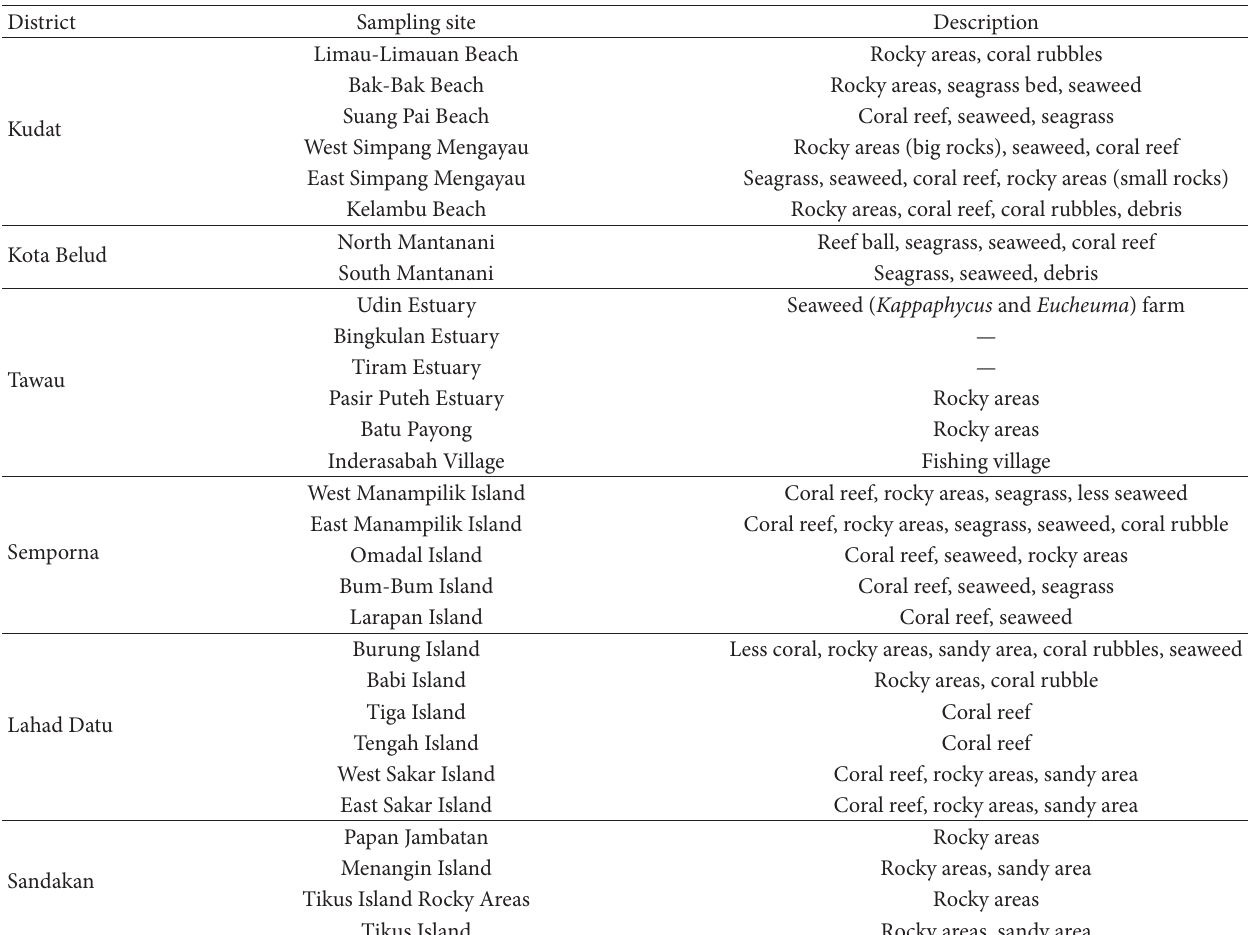
Table 7: The description of habitat at each sampling site by